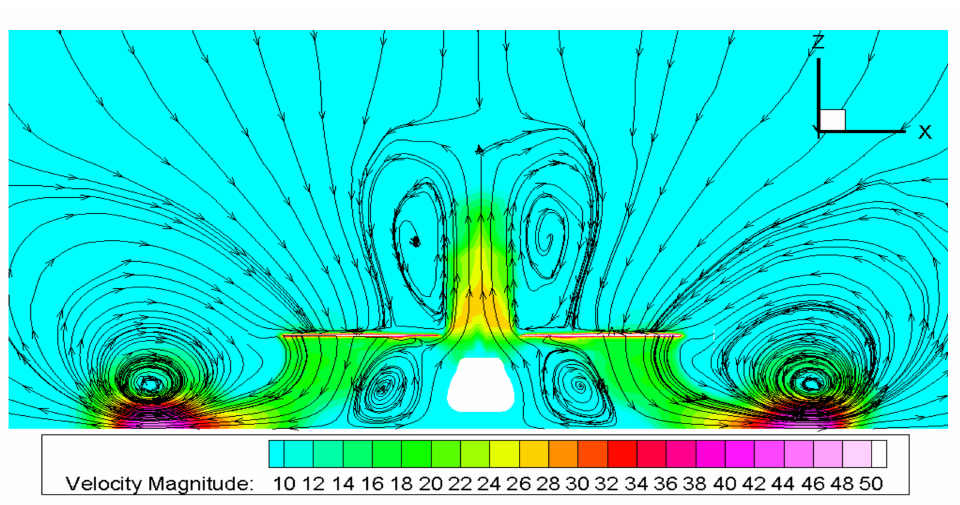
Figure 7. Section velocity contours and streamline